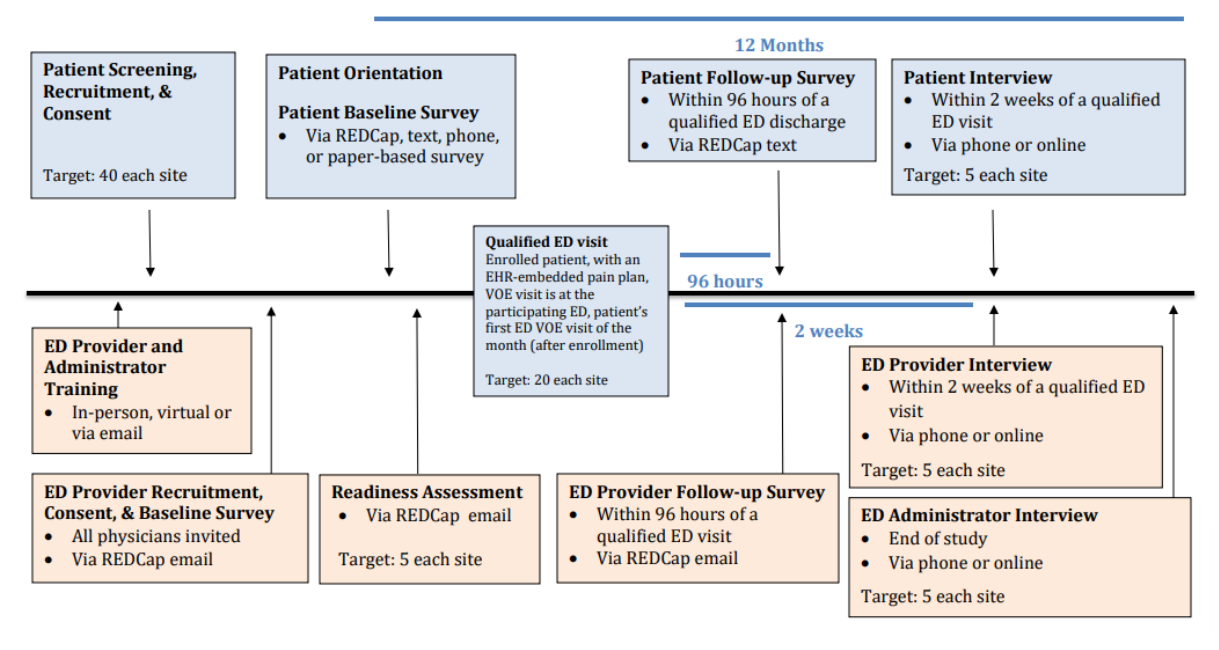
Figure 4. Study flow chart. ED: emergency department; EHR: electronic health record; VOE: vaso-occlusive